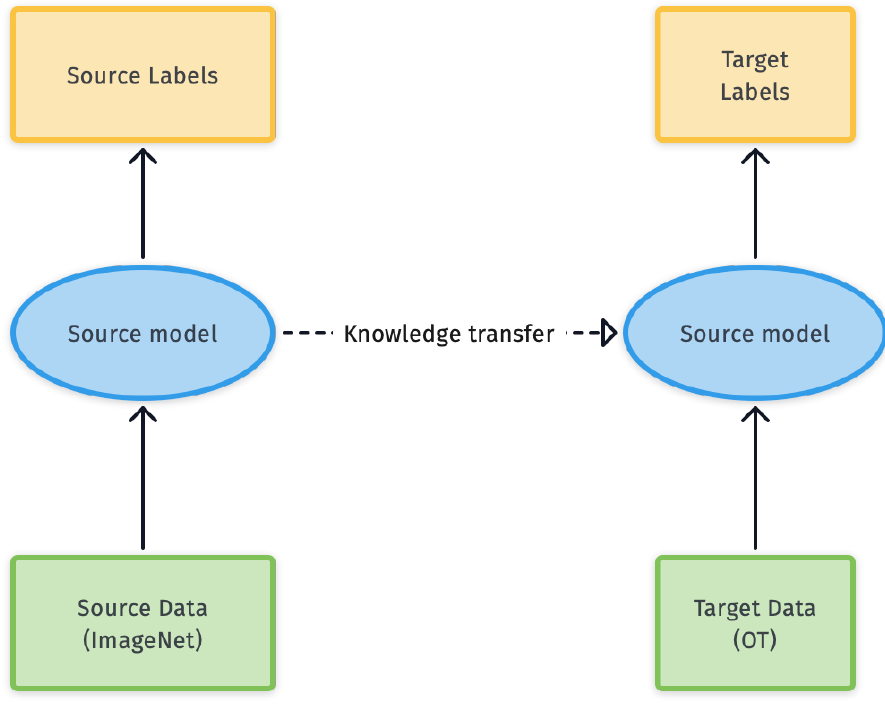
Figure 4. A schematic overview of transfer